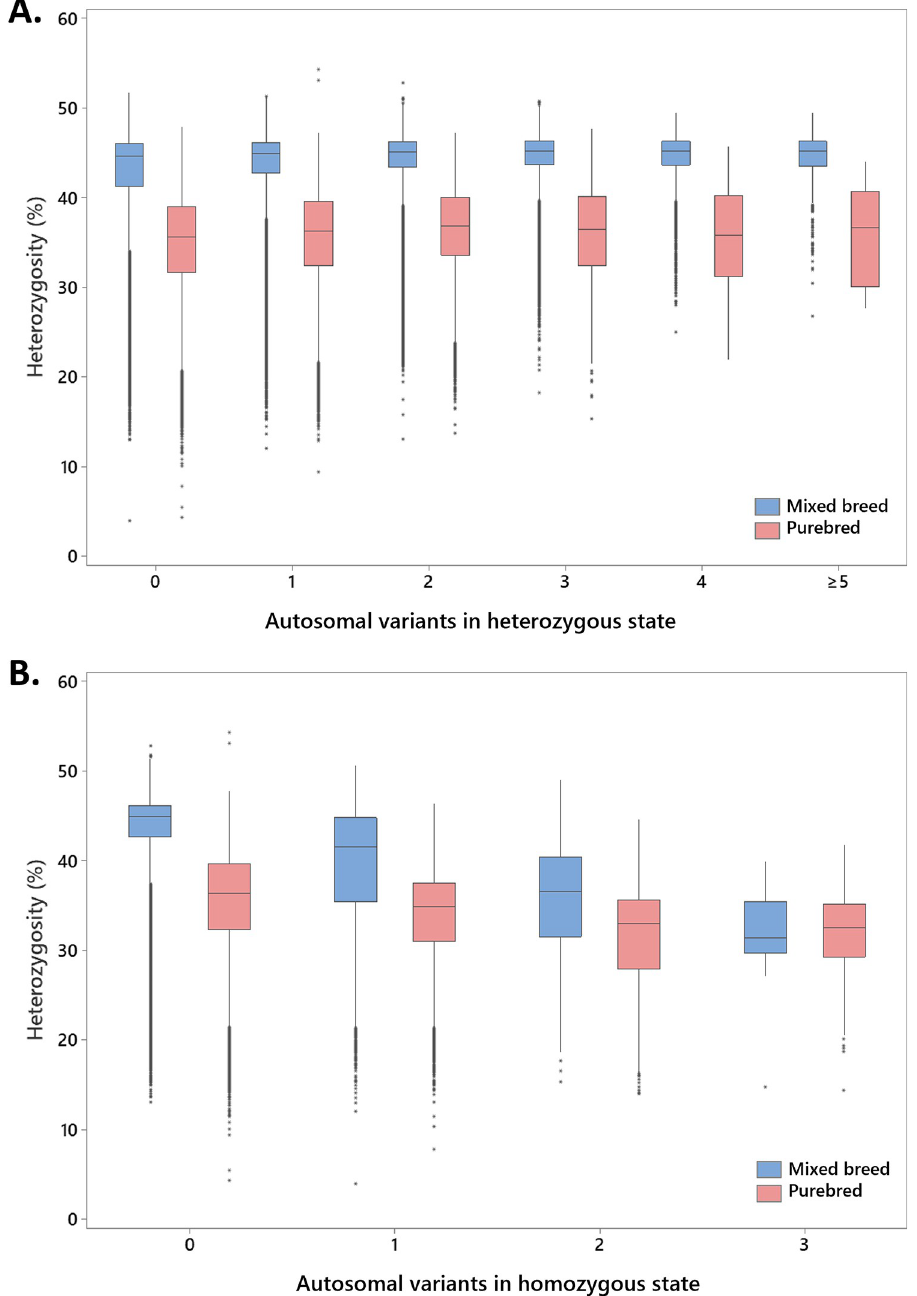
Fig 3. The relationship between genome-wide genetic heterozygosity and autosomal disease-associated variants present in A) heterozygous state and B) homozygous state; based on 178 recessive and 13 semi-dominant or dominant variants tested in 1,054,293 dogs. Medians and interquartile range boxes representing the middle 50% and whiskers representing the bottom and top 25% of the data excluding outliers (data points > 1.5x the interquartile range from the boxes; asterisks) are